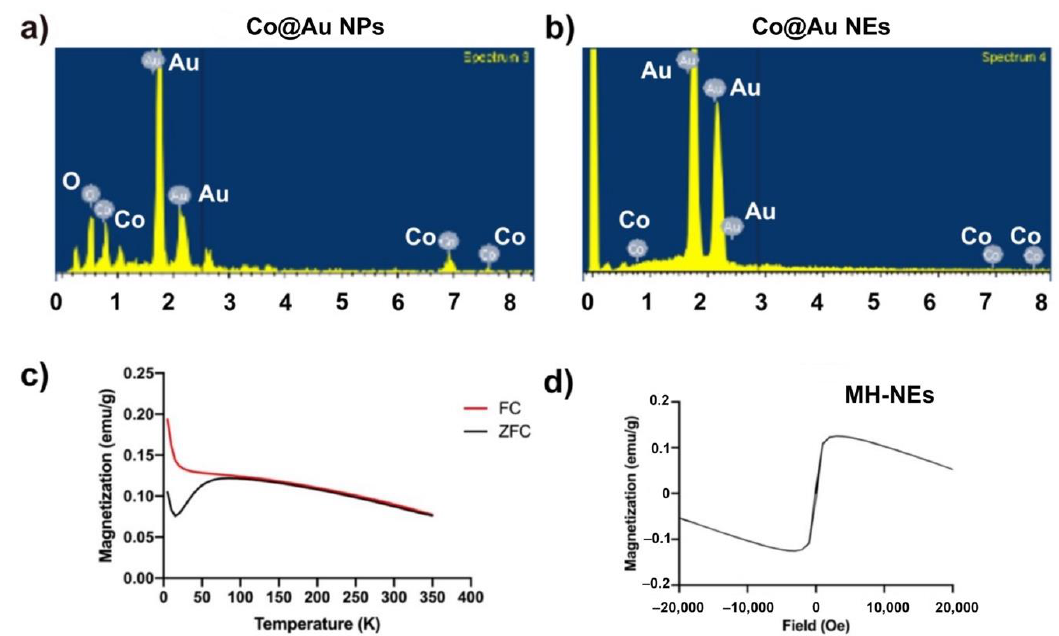
Figure 2. Characterization of round Co@Au nanoparticles (Co@Au NPs) and elliptical Co@Au (Co@Au NEs) nanoparticles composition using EDS and SQUID. ( a , b ) Elemental composition analysis of Co@Au NPs and NRs via EDS. ( c , d ) Analysis of magnetic properties of Co@Au NRS via SQUID. FC — field-cooled, ZFC — zero-field cooled. Table 1. Analysis of Co@Au NPs and Co@NEs composition.